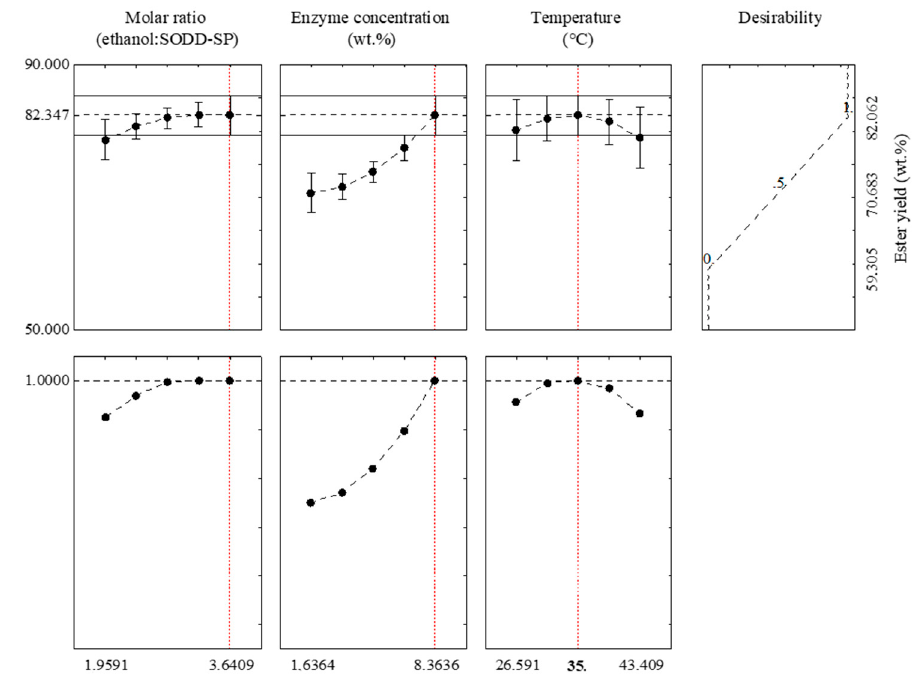
Figure A3. Profiles for predicted values and desirability of the esterification/transesterification with SODD saponifiable phase and ethanol using Eversa Transform 2.0 as biocatalyst. Table A1. Studies of biodiesel production using Eversa ® Transform lipase (liquid or immobilized) as biocatalyst. Acyl